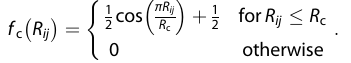
Fig. 8 Interactions resulting in non-zero values of the radial and angular spin-augmentation functions. Red circles with a zero represent atoms with s = 0, purple circles with a plus sign atoms with s = 1, and blue circles with a minus sign atoms with s = − 1. The fi rst atom of each entry is the central atom i of the sACSF. The order of the neighbor atoms in the angular interactions is insigni fi cant. The inverse interactions (i.e., switching “ + ” and “ − ” ) yield the same result and are not shown for with the cutoff function